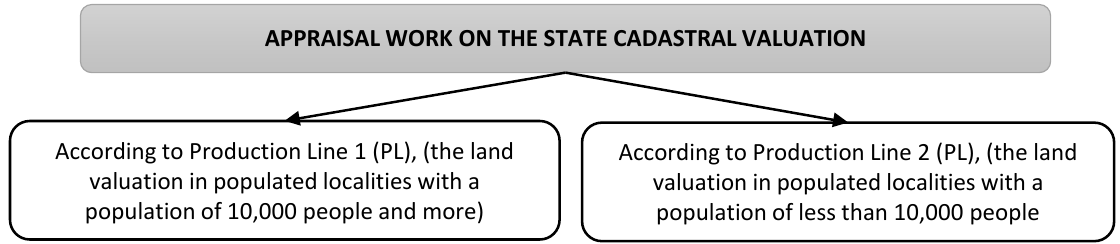
Figure 1. Implementation of the state cadastral land